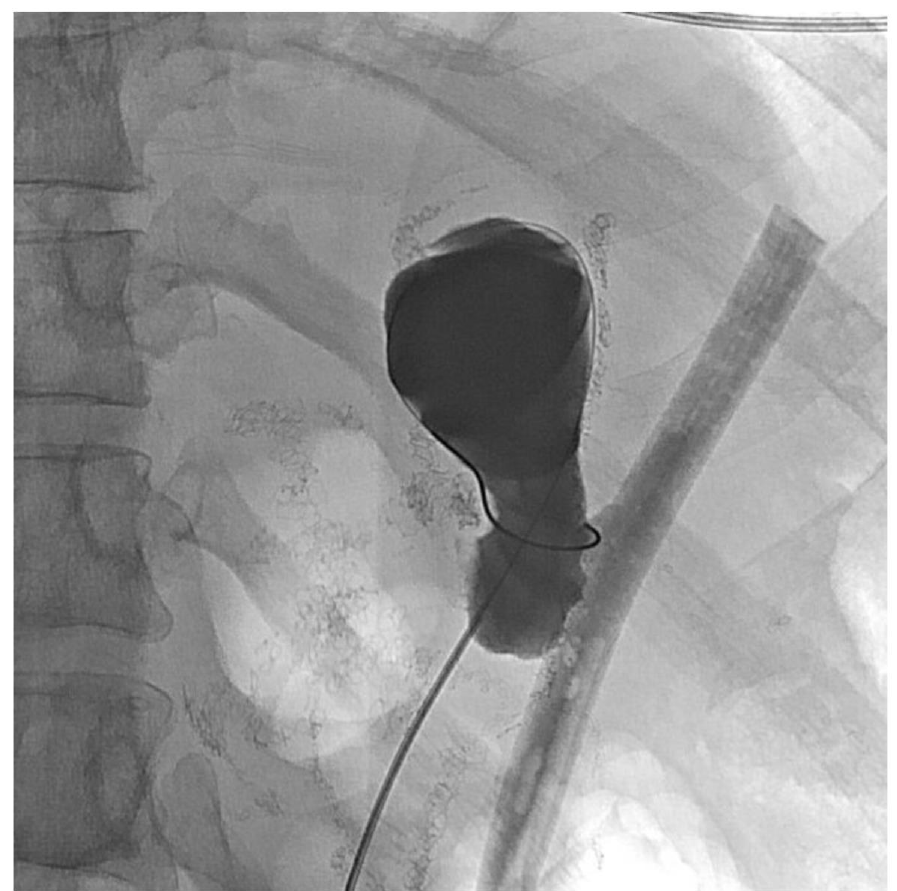
Figure 12. Wire definitely in orphaned stomach segment.